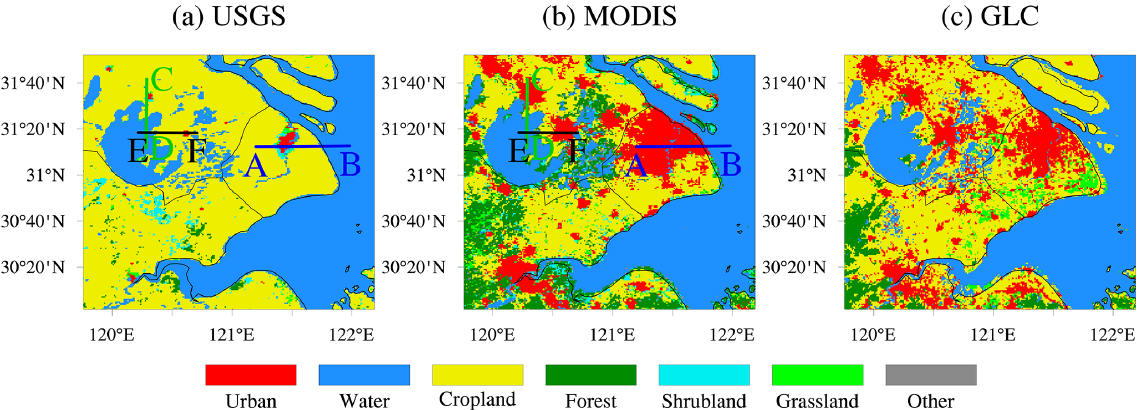
Figure 2. Land cover maps in the innermost domain, with (a) USGS, (b) MODIS and (c) GLC